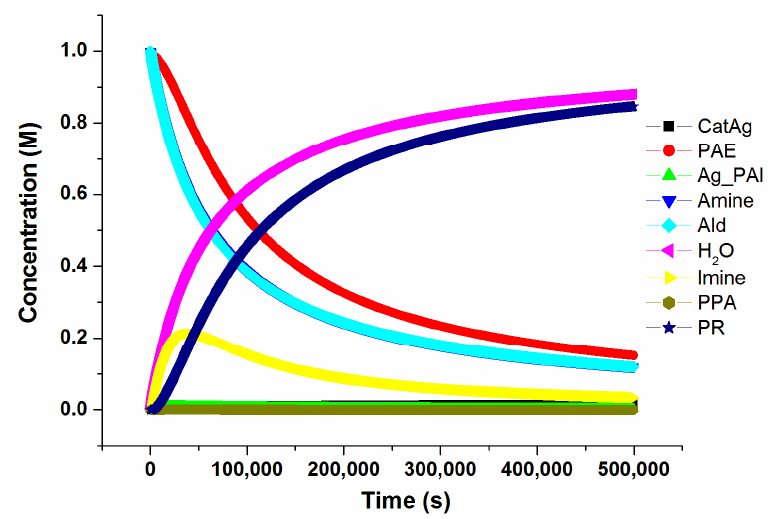
Figure 12. The change in the concentration of various substances over reaction